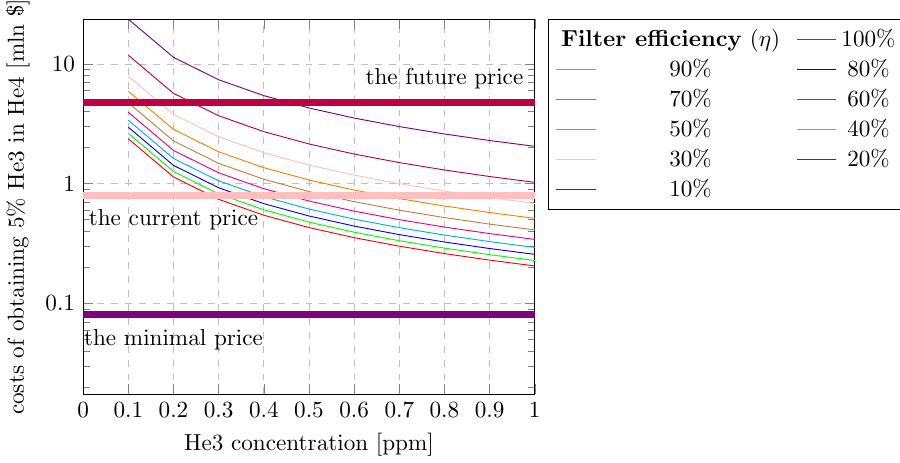
Figure 4. Cost of production He3 for low